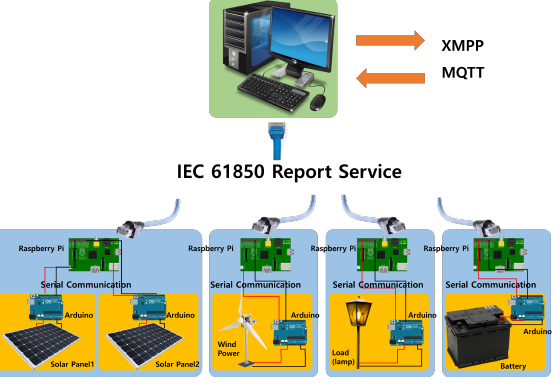
Figure 7. Configuration of the micro grid.